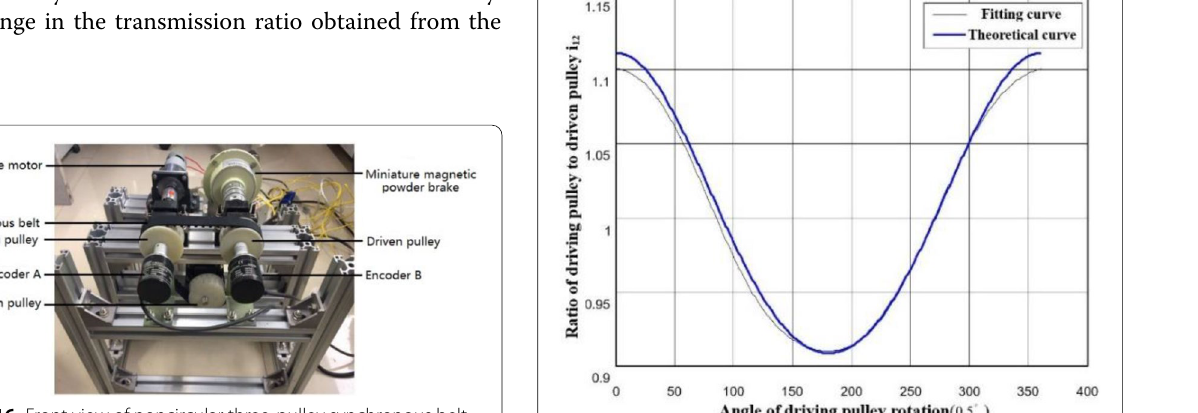
Figure 16 Front view of noncircular three-pulley synchronous belt transmission mechanism test rig